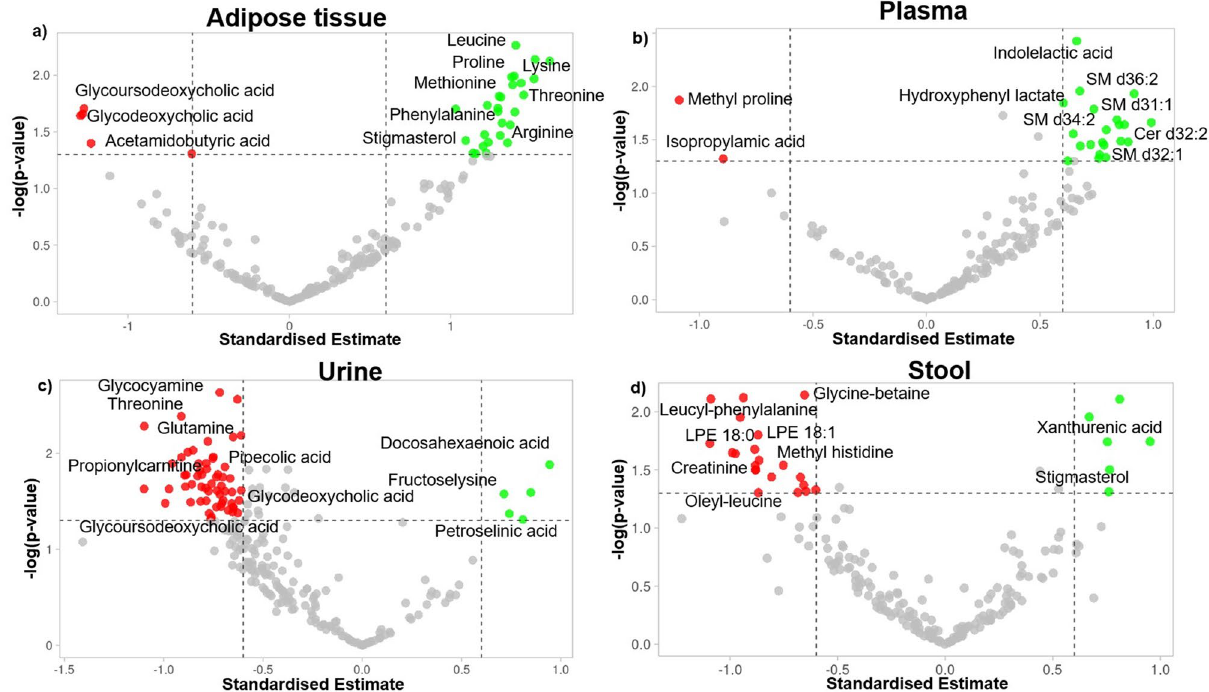
mixed model for the interaction between group (controls and intervention) and time (baseline and endpoint of the exercise intervention) versus the negative logarithm of the raw p-values. Thresholds are shown as dashed lines. Metabolites selected as significantly increased in the intervention group are highlighted as green dots, and those decreased significantly in the intervention group compared to the controls are shown as green